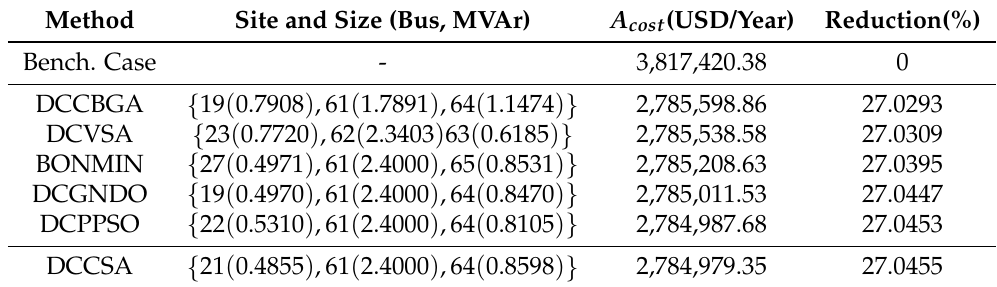
Table 5. Numerical results for the DC version of the 69-bus feeder.